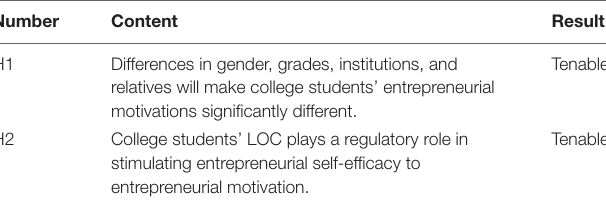
TABLE 3 | Test results of